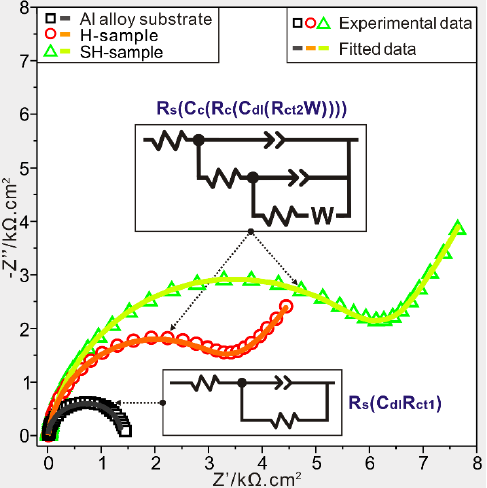
Figure 6. Nyquist plots of Al alloy substrate, modified substrate (H-sample) and modified deposited sample (SH-sample). The inserts referring to equivalent circuit patterns of the substrate and modified samples.